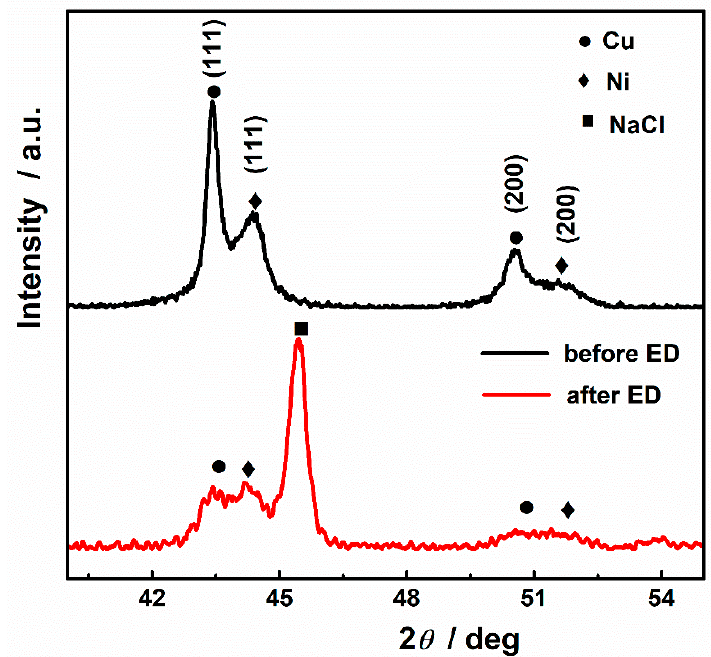
Figure 6. XRD patterns of the CuNi NPs (before ED) and the freestanding hydrogel (after ED) in the 40–55° 2 θ region. Peaks denoted by ● , ◆, and ■ belong to Cu, Ni, and NaCl, respectively; ED stands for electrodeposition. Table 2. Composition of the Ni-rich and Cu-rich phases present in the CuNi NPs and chitosan freestanding film, as determined from XRD